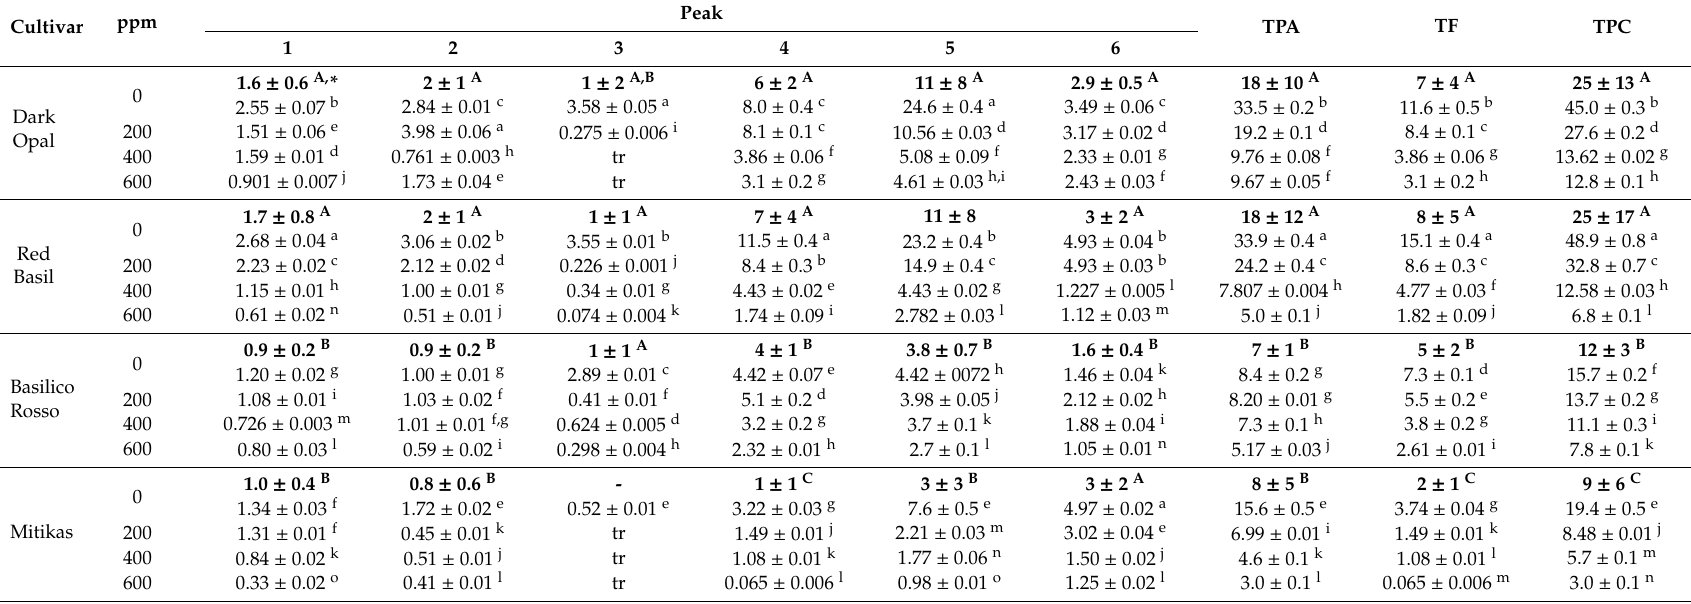
Table 5. Quantification (mg / g of extract) of the phenolic compounds present in the hydroethanolic extracts of the studied basil genotypes in relation to nitrogen input (mean ± SD, n =